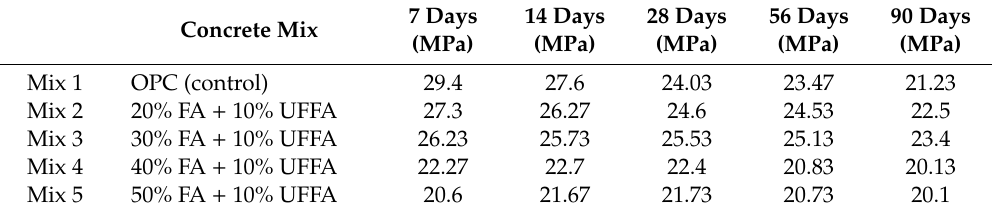
Table 6. Loss of compressive strength in acidic environments